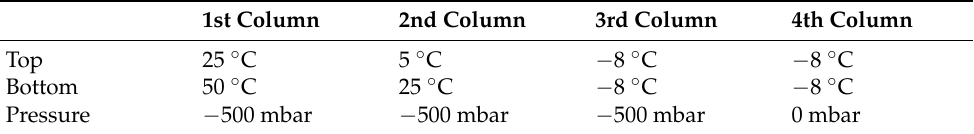
Table 3. Temperature settings of each column for Chinook extraction.